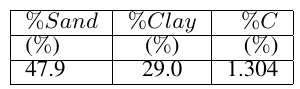
Table 1. Intrinsic soil properties